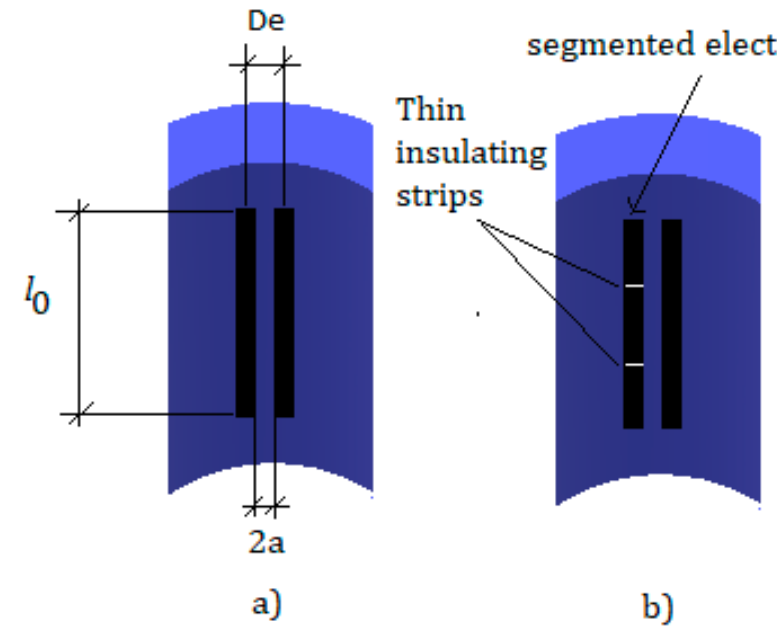
Figure 6. ( a ) Conductance probe with two parallel rectangular electrodes, ( b ) similar probe with one of the electrodes segmented as designed by Coney [10].